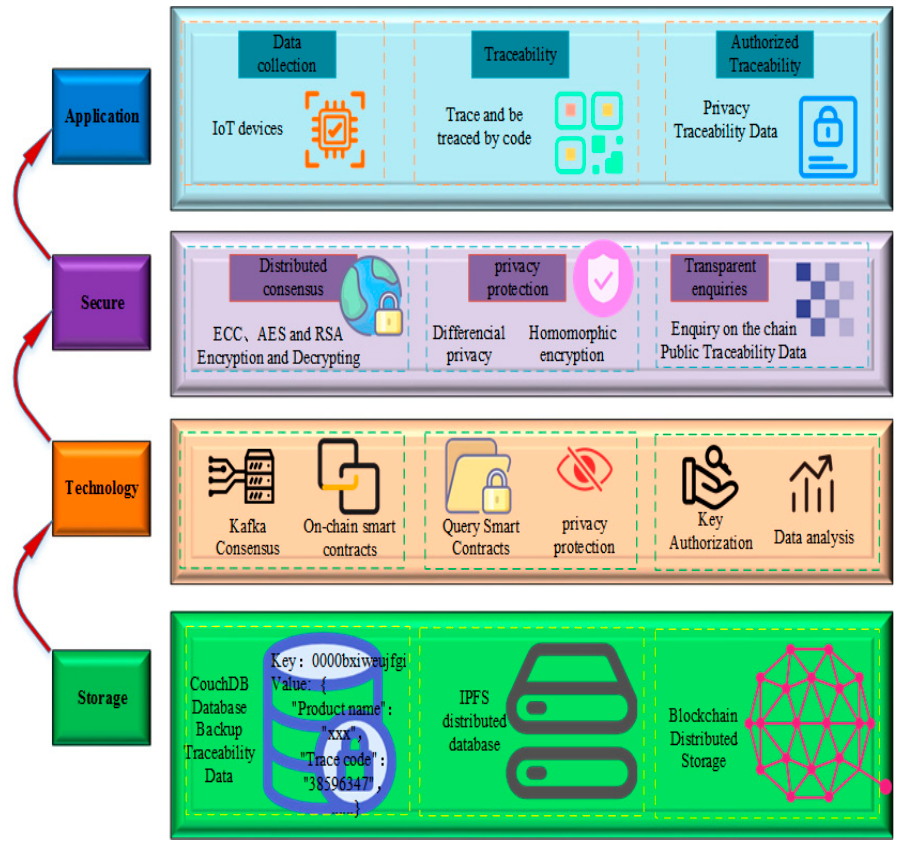
Figure 2. The internal structure of the safety traceability system.